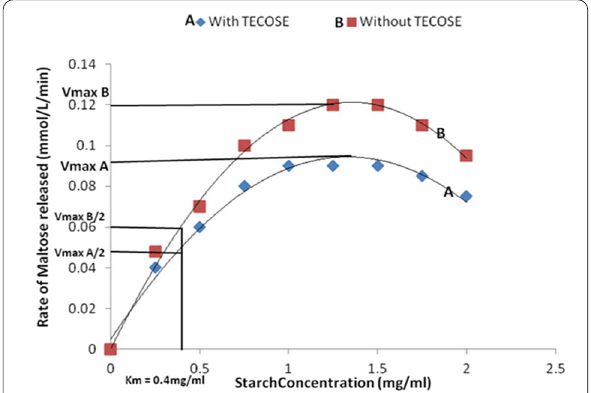
Fig. 4 Rate of maltose released from starch by α-amylase in the presence and absence of TECOSE